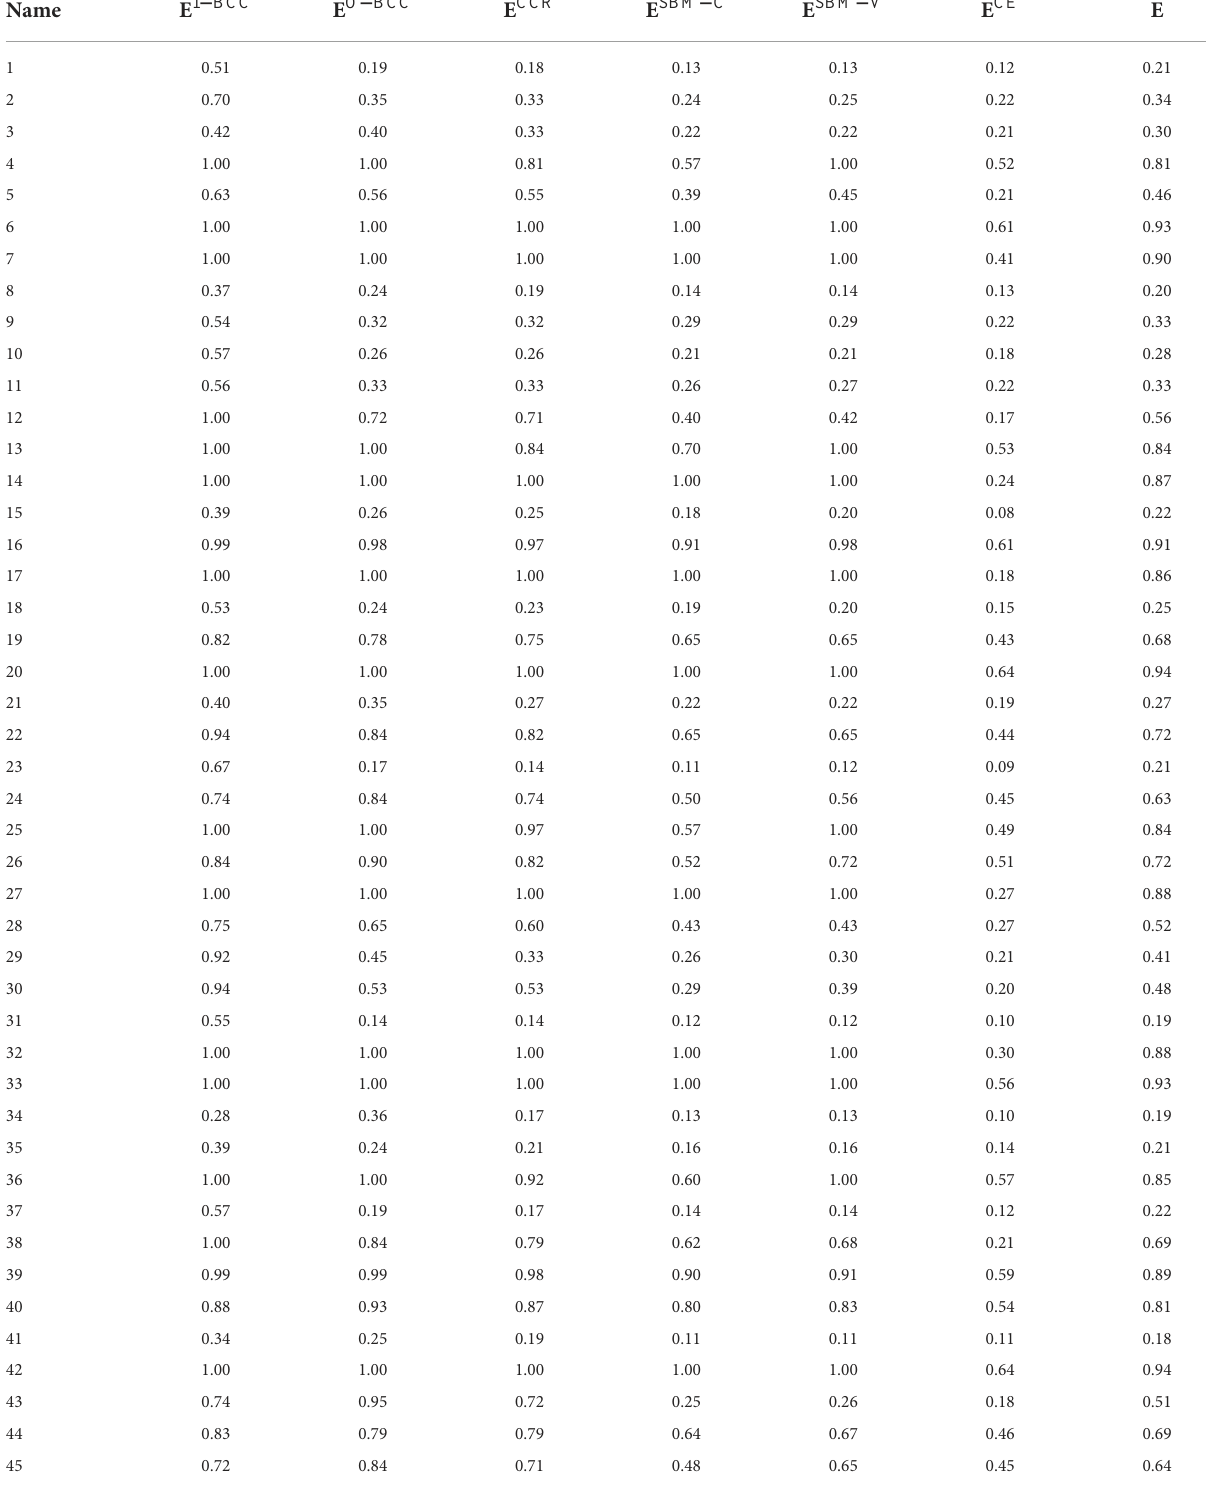
TABLE 2 Comprehensive work efficiency measured by the Gini impurity-based integrated DEA